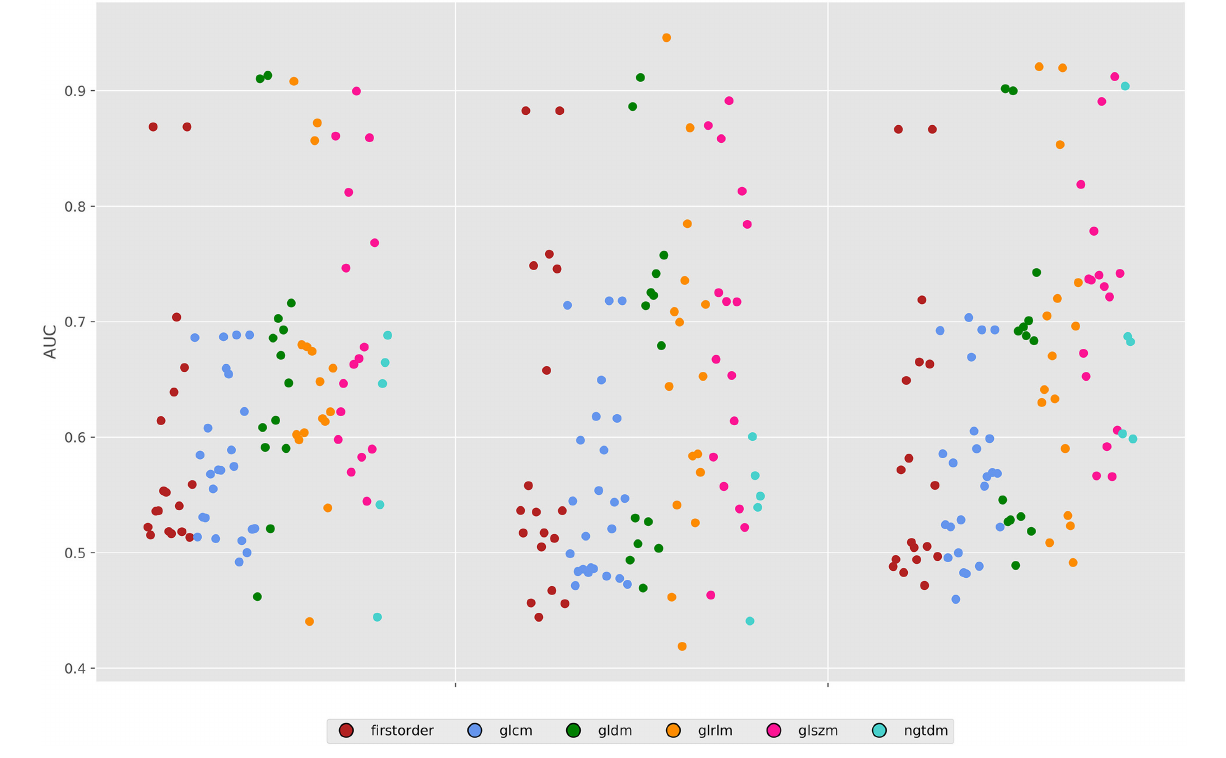
FIGURE 3 | Area under the ROC curves for all features across both energy levels and the 50% combined image. GLDM, Gray level dependence matrix; GLCM, gray Level Co-occurrence matrix; GLRLM, gray level run length matrix; GLSZM, gray level size zone matrix; NGTDM, neighboring gray tone difference